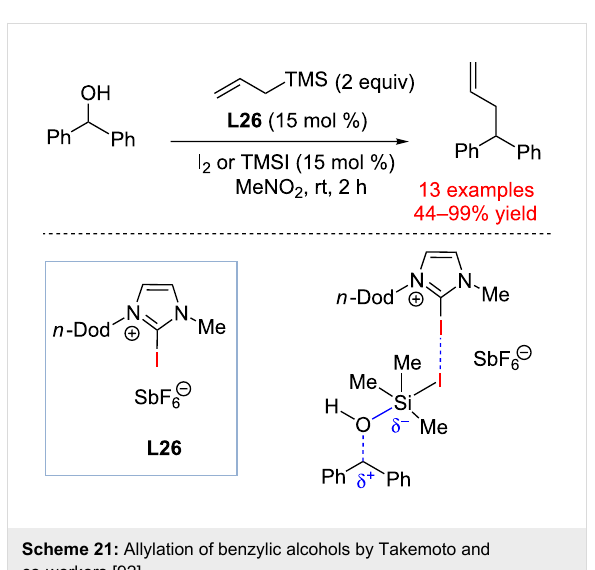
Scheme 21: Allylation of benzylic alcohols by Takemoto and co-workers